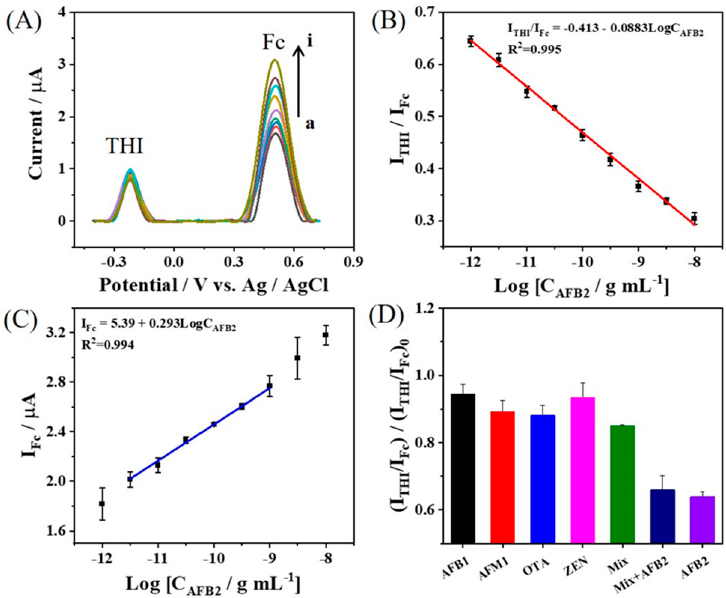
Figure 4. ( A ) ACV responses of the aptasensor to AFB2 with a concentration of (a–i): 0.001, 0.003, 0.01, 0.03, 0.1, 0.3, 1, 3, and 10 ng mL − 1 . Calibration plot of ( B ) I THI /I Fc and ( C ) I Fc vs. the logarithm of the C AFB2 . ( D ) Comparisons of the aptasensor responses to 0.01 ng mL − 1 solution of AFB2 and 0.2 ng mL − 1 solution of AFB1, AFM1, OTA, ZEN, and the mixture of the interferences.